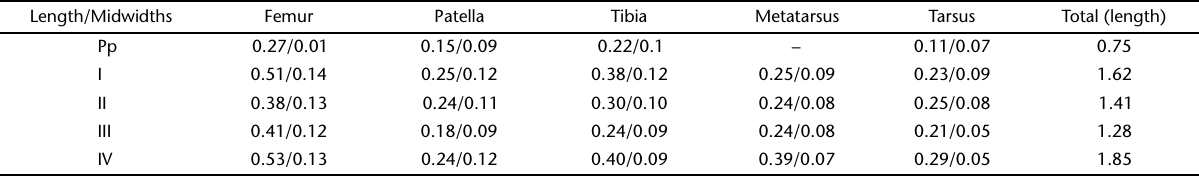
Table I. Masteria manauara sp. nov. Male holotype (INPA 8598). Length and midwidths of right legs and palpal segments. Length/Midwidths